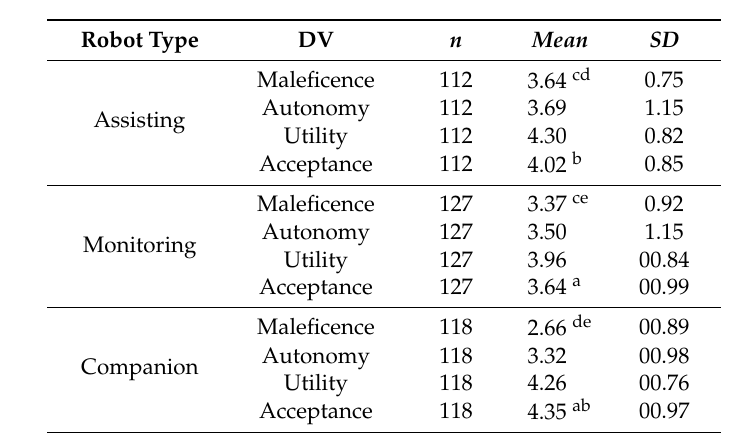
Table 3. Descriptive statistics (Mean, Standard Deviation ( SD )) of the four dependent variables (DV) ( N =